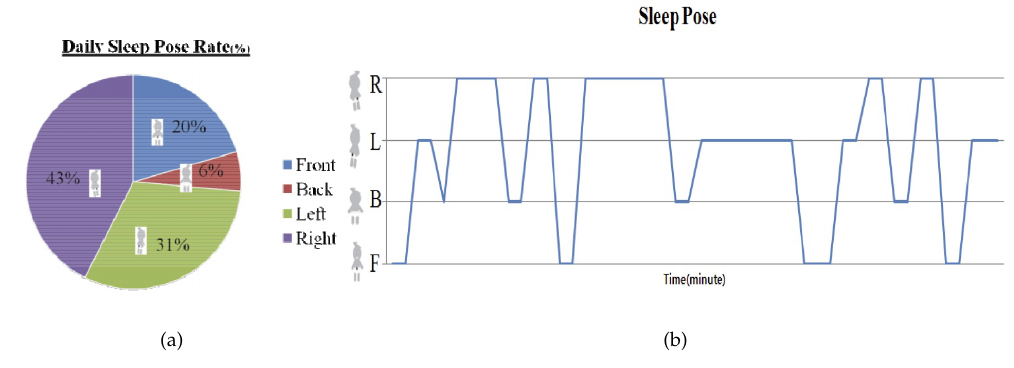
Figure 9. Results of the sleeping pose rate and sleeping pose detection. ( a ) Sleeping pose rate; ( b ) Sleeping pose detection.